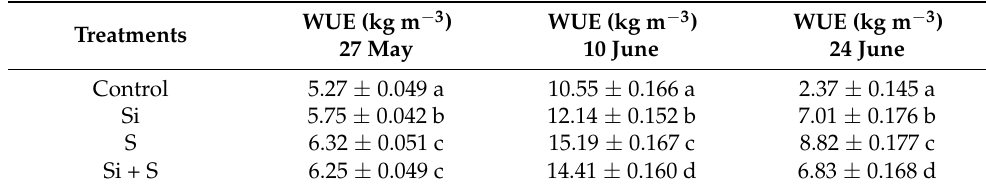
Table 2. Effect of treatments on water use efficiency (WUE) of oat. Mean of the varieties and standard errors (2021,